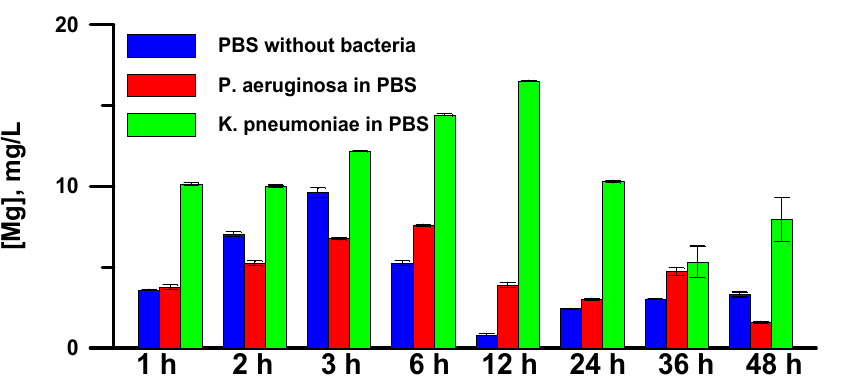
Figure 7. Variation in magnesium concentration in liquid phase with the duration of contact between the MA8 alloy sample with a superhydrophobic coating and PBS with or without bacterial cells. The nonmonotonic increase in Mg 2+ concentration over time for all three considered liquid media is seemingly determined by the kinetics of the formation of the covering films and the rods on the surfaces of the superhydrophobic samples. Since the superhydrophobic surface is characterized by an increased energetic barrier for the heterogeneous nucleation of the surface phases [35], we observed an increase in the concentration of magnesium ions that reached the saturation levels necessary to start the mass formation of a new phase (Figure